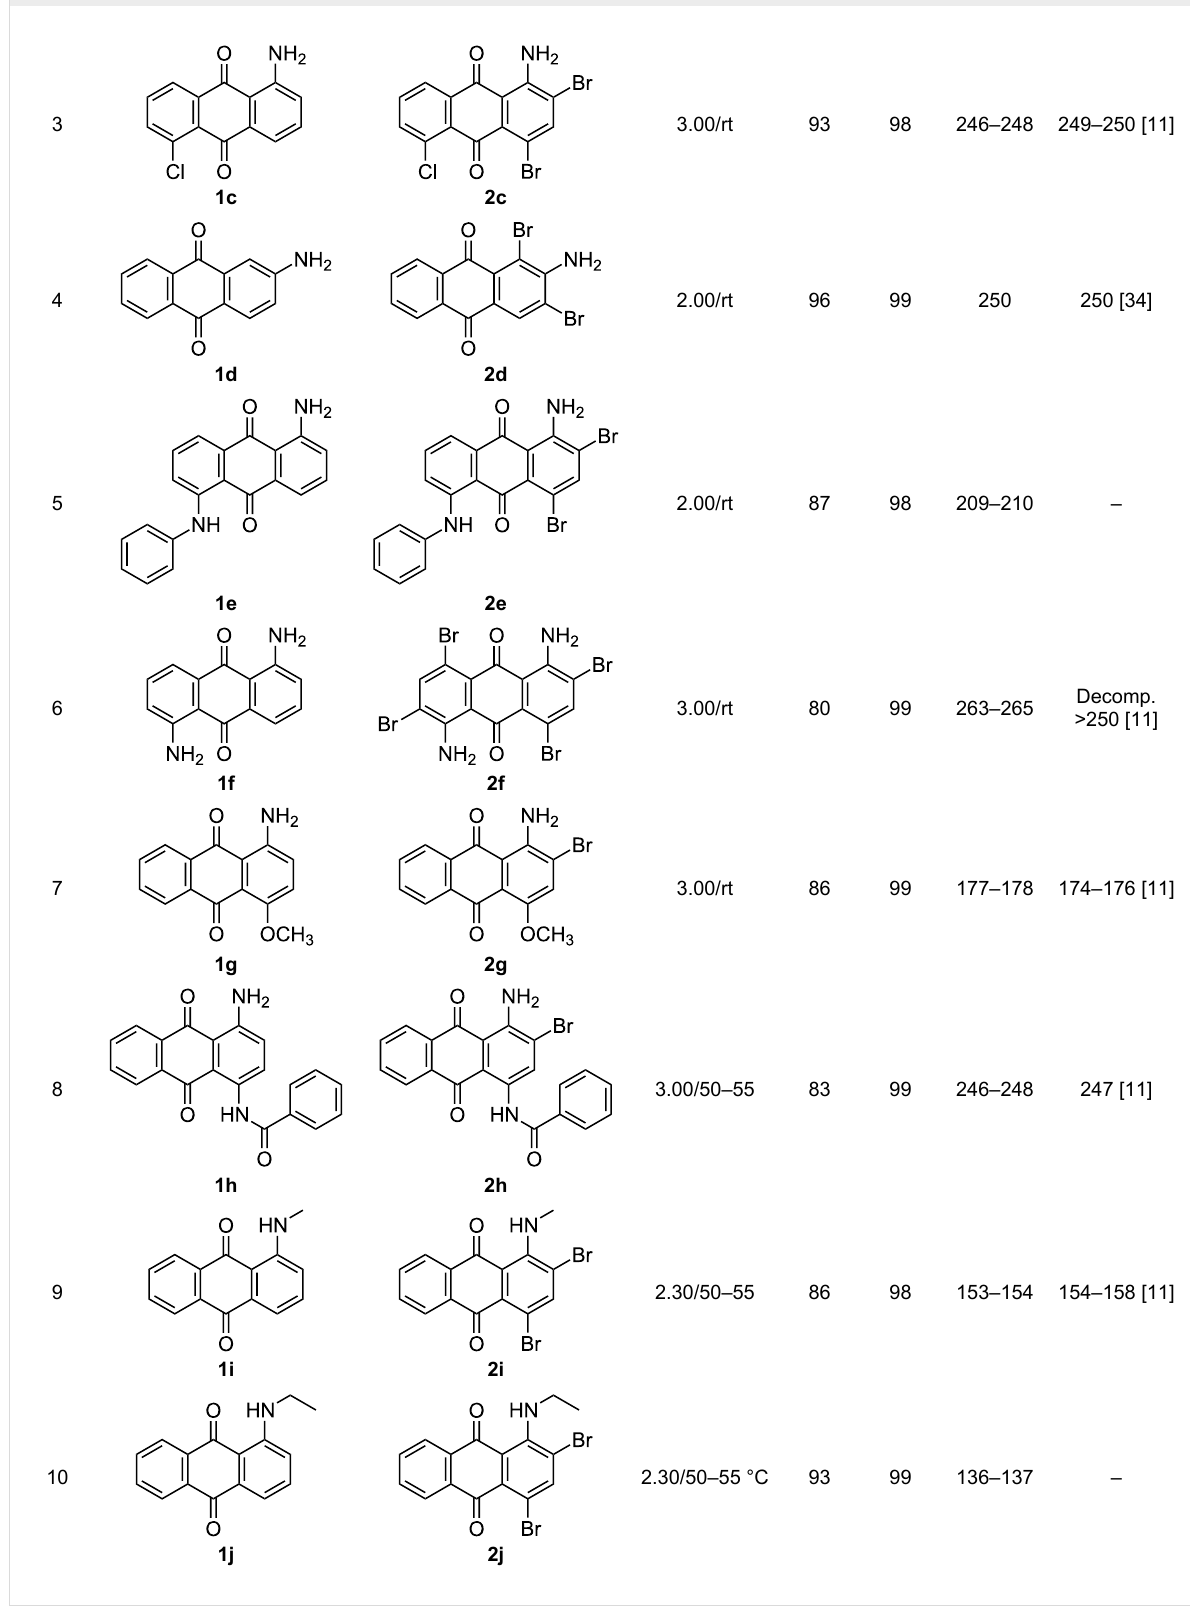
Table 4: Bromination of various aminoanthracene-9,10-dione derivatives and benzanthrone. a